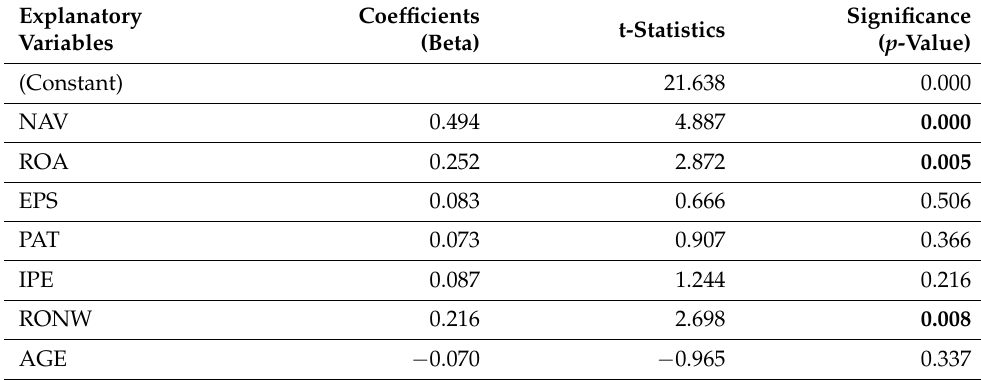
Table 6. Results of Model 1 for Offer Price